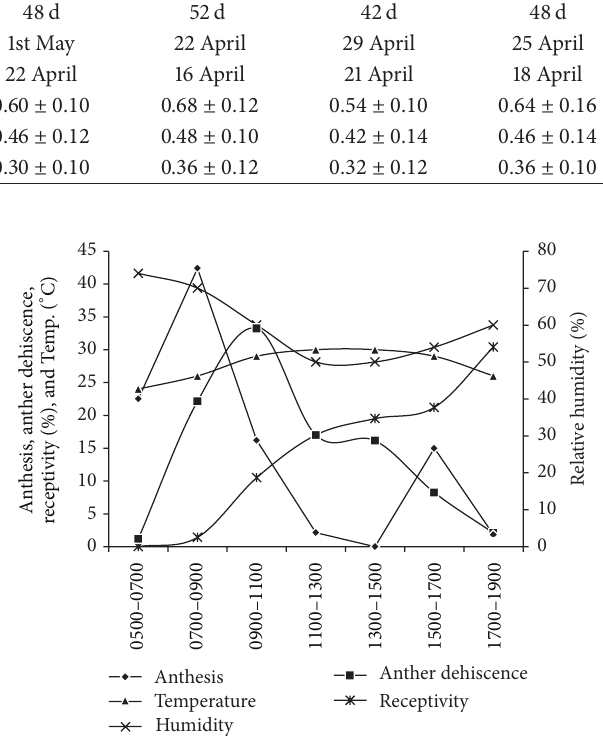
Figure 2: Pattern of anthesis, anther dehiscence and stigma recep- tivity in relation to the time of the day in S.